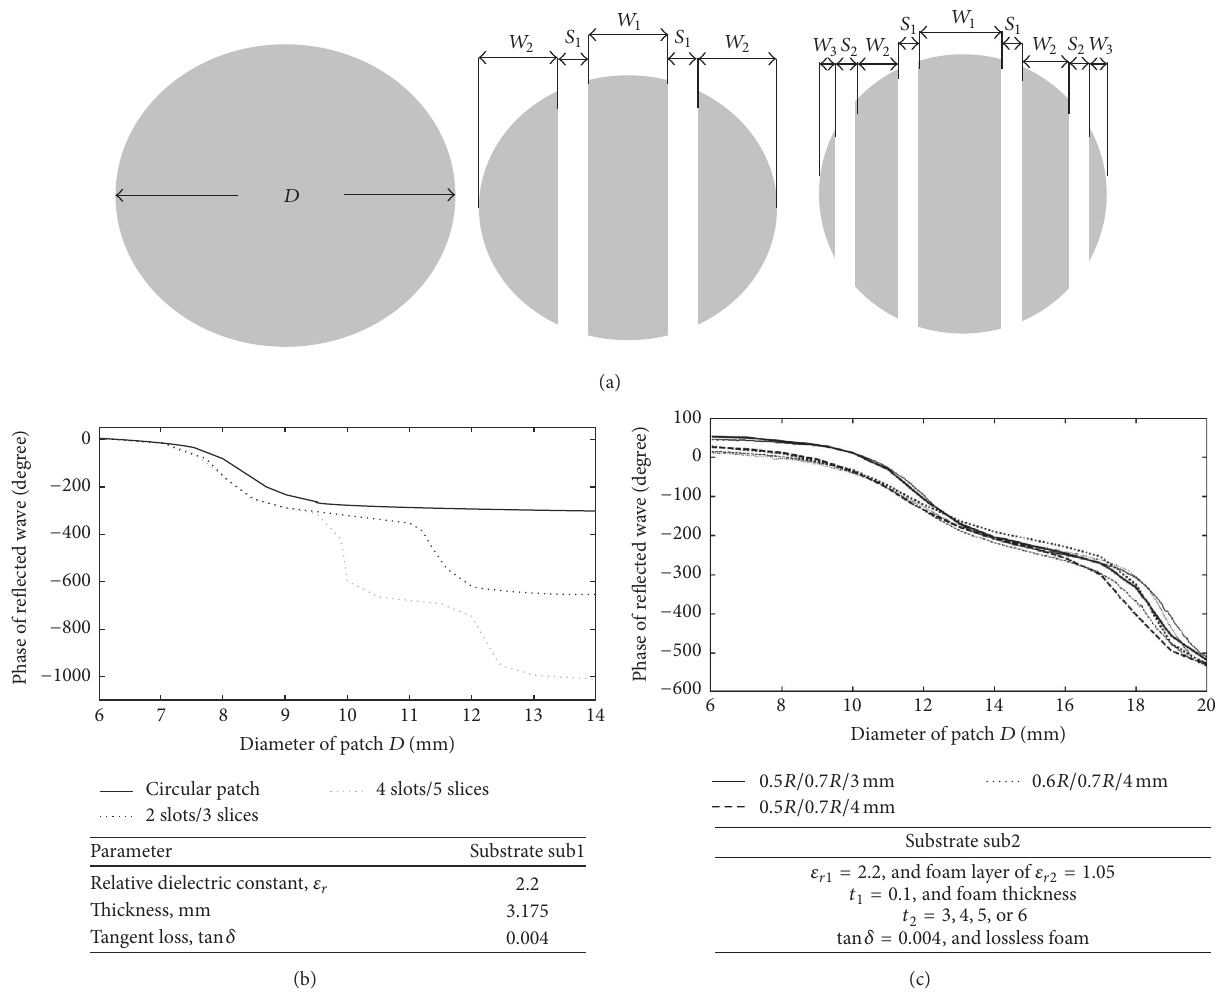
Figure 2: (a) Sliced-circular fractal; (b) simulated phase response versus patch diameter of circular patch and sliced-circular fractals with two-slots and four-slots ( 𝑓 0 = 10 GHz); (c) linearized phase responses of two-slot sliced-circular fractal for different slices widths and foam substrate layer